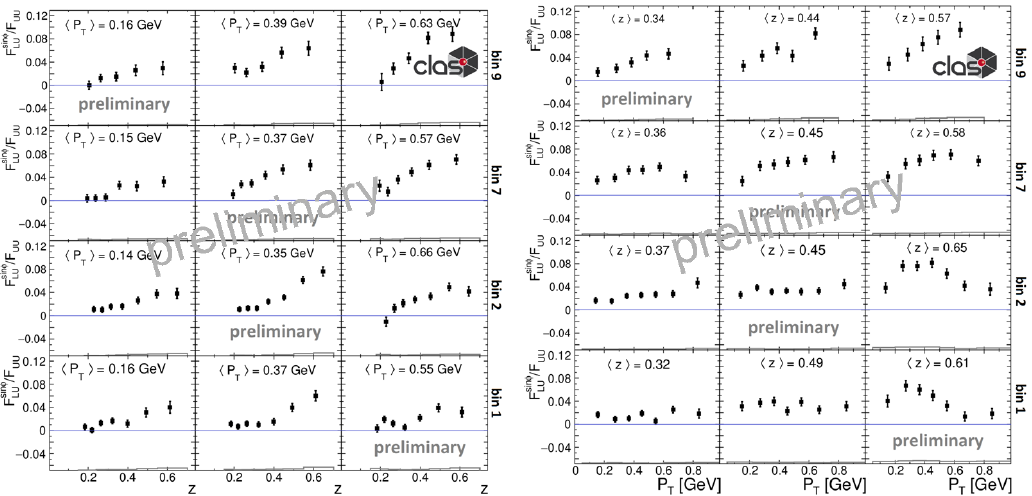
φ / F for π + in UU LU bins. The systematic B